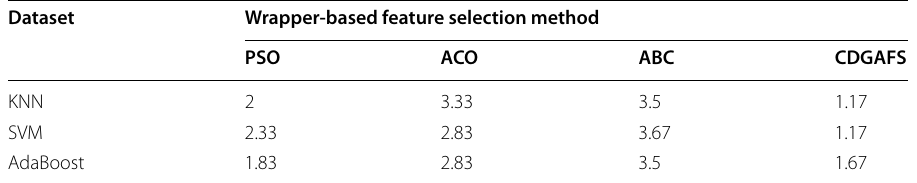
Table 6 Average ranks of the different EA-based feature selection methods on SVM, NB, and AB